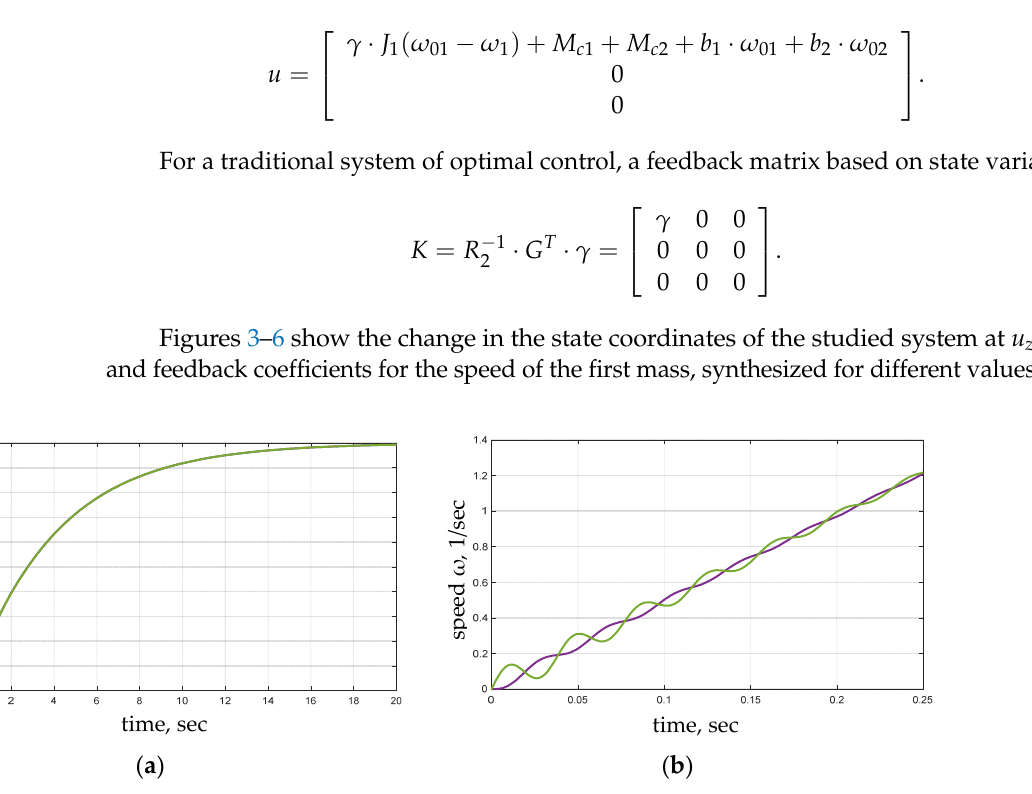
Figure 3. Dependences of speed change in the first (green) and second (purple) masses during acceleration for γ = 0,5 : ( a ) acceleration to the desired value; ( b ) the beginning of the acceleration.